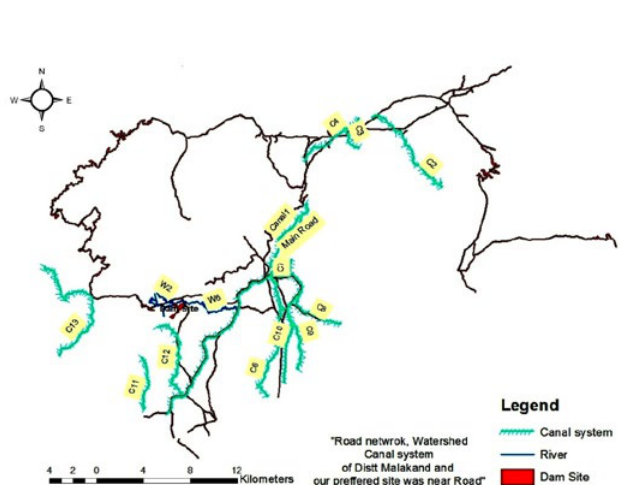
Fig. 6. Slope classes Fig. 6: Slope classes